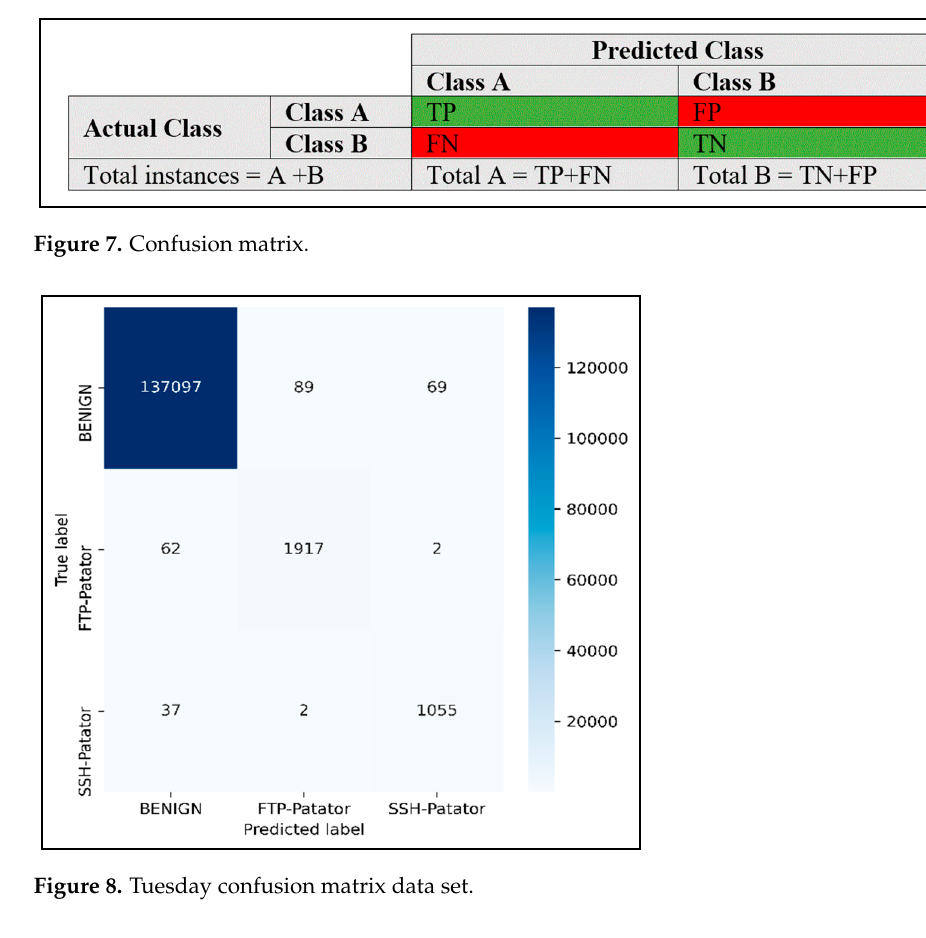
Figure 8. Tuesday confusion matrix data set.